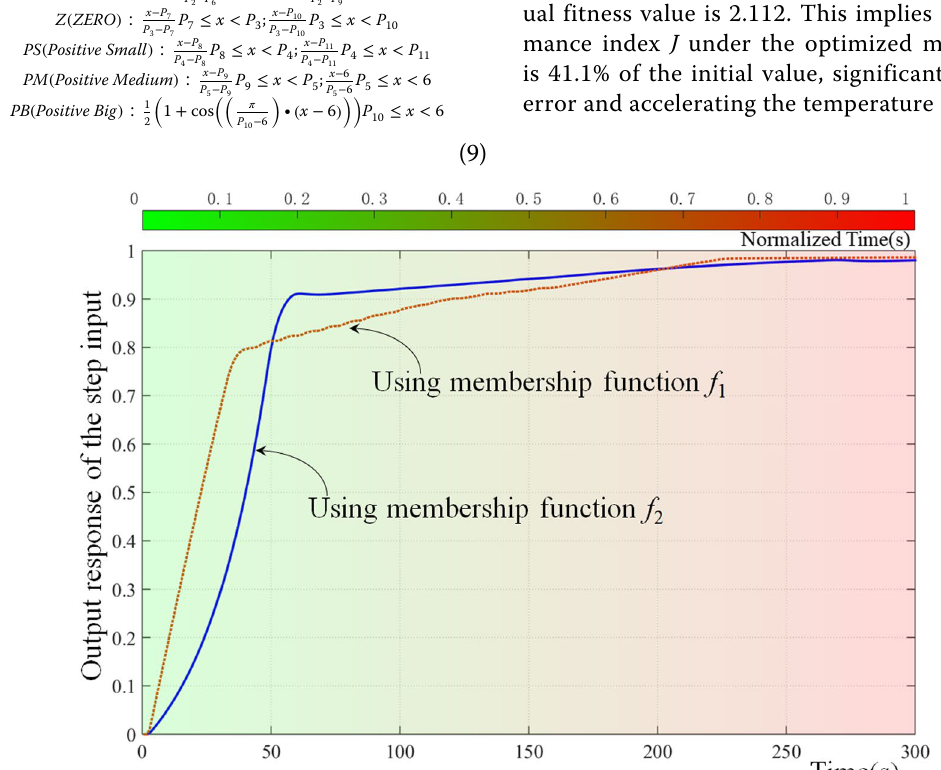
Fig. 2 Comparison of the response curve before and after genotype change, where using membership function f 1 and f 2 , the stable value is 0.9861 and 0.98, rise time is 108 and 55, peak time is 300 and 270 alongwith peak value 0.9861 and 0.9805, overshoot is nearly zero and 0.05%, settle time is 175 and